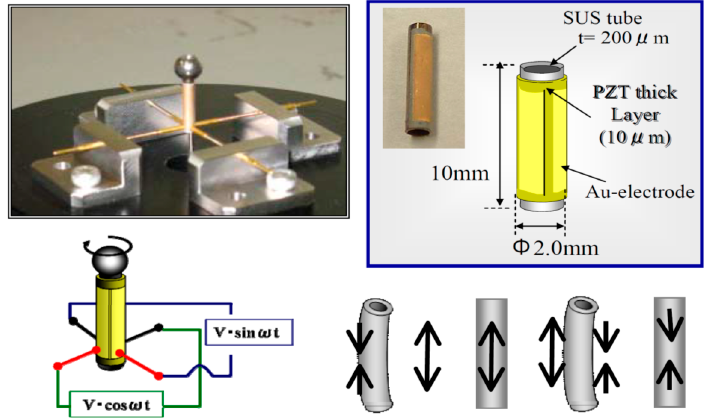
Figure 24. Tube-type ultrasonic motor driven with a PZT thick film layer deposited on an STS tube via AD [17]. © Copyright 2007,